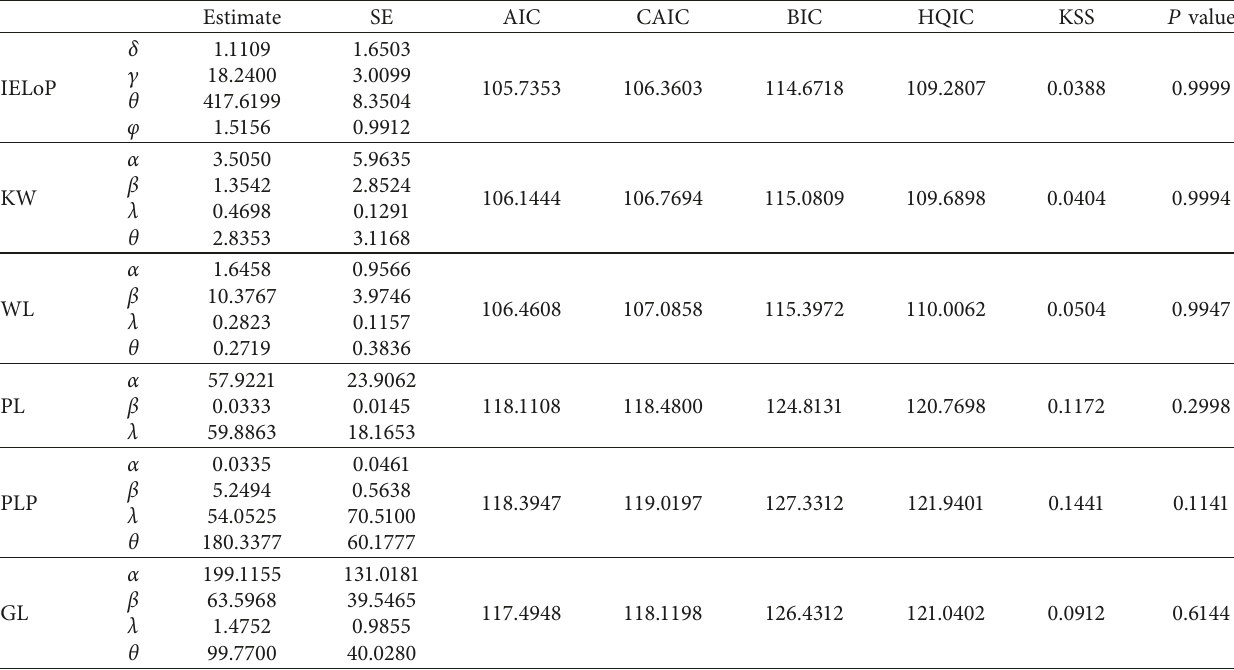
Table 9: MLE, SE, different measures, and KSS test for the fitted models for dataset